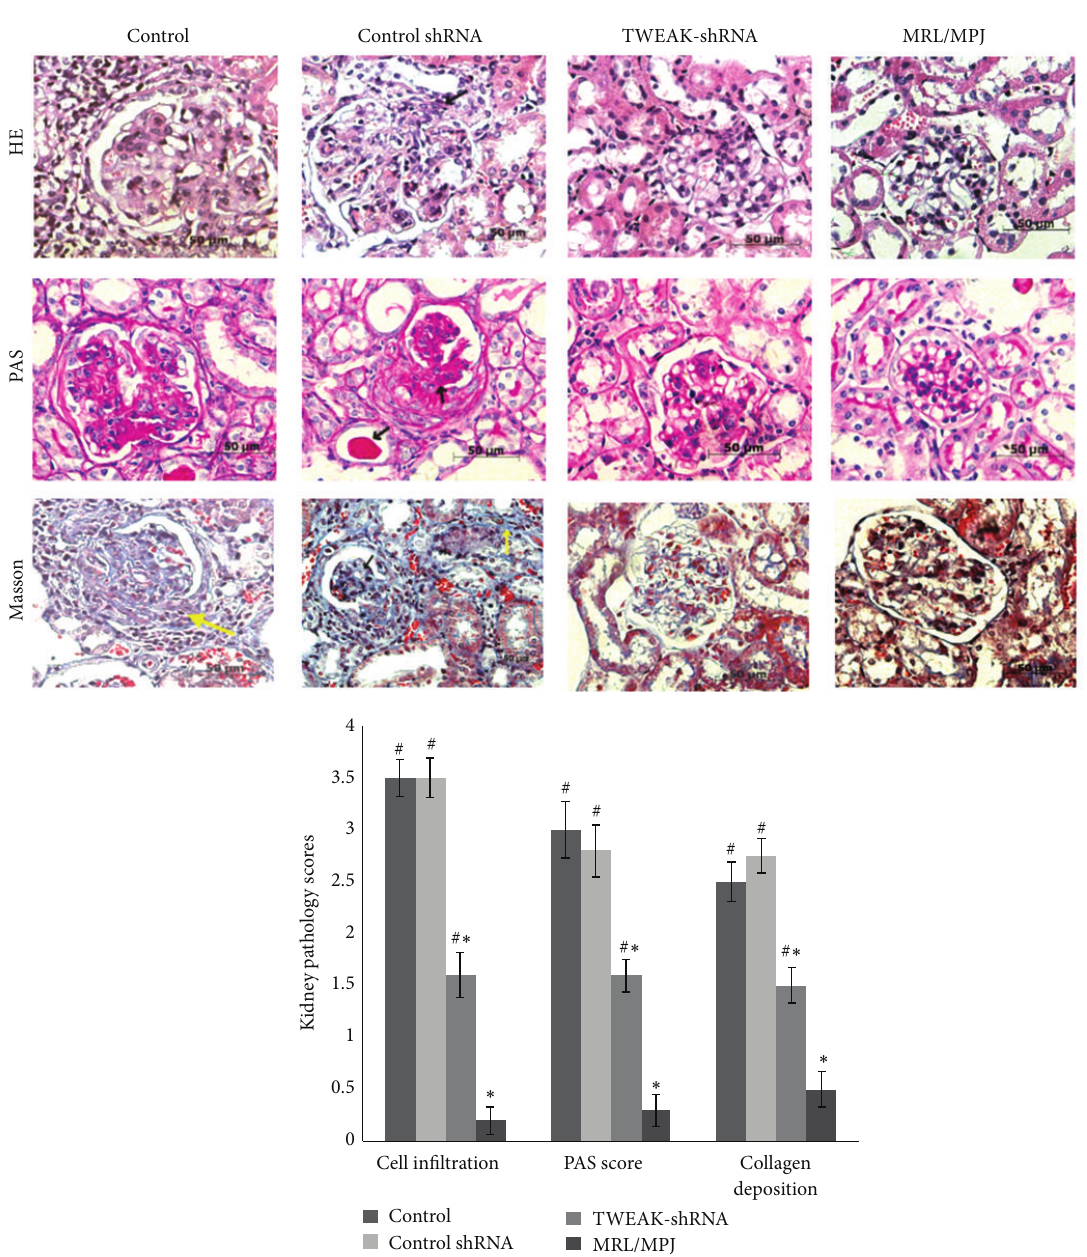
Figure 1: LV-TWEAK-shRNA treatment alleviated histopathological changes in kidneys of MRL/lpr mice. HE representative hematoxylin and eosin- (H&E-) stained sections of formalin-fixed kidneys. PAS representative micrographs of periodic acid-Schiff- (PAS-) stained sections from paraffin-embedded tissues. Masson representative micrographs of Masson-stained sections of paraffin-embedded tissue of the glomerular and interstitial. The kidney pathological scores of cell infiltration and PAS-positive and collagen deposition were shown at the bottom. Compared with those from MRL/MPJ mice, the kidneys from MRL/lpr mice which were treated with PBS or LV-Control shRNA had severe inflammatory infiltrates and histopathology changes, such as a large PAS-positive deposit in the glomeruli (black arrows), segmental overlying cellular crescent sclerosis, crescents, and periglomerular infiltrates, and accumulation of numerous fibroblasts (yellow arrows); damaged kidney tubules and blood vessels were also evident. The kidneys from MRL/MPJ mice showed intact glomerular and tubulointerstitial structures and very few fibroblasts. Control: MRL/lpr mice treated with PBS; Control shRNA: MRL/lpr mice treated with LV-Control shRNA; TWEAK-shRNA: MRL/lpr mice treated with LV-TWEAK-shRNA; and MRL/MPJ: MRL/MPJ mice as normal control. The error bars represent the standard deviation. # 𝑝 < 0.05 versus MRL/MPJ mice and ∗ 𝑝 < 0.05 versus control MRL/lpr mice. Scale bar: 50 𝜇